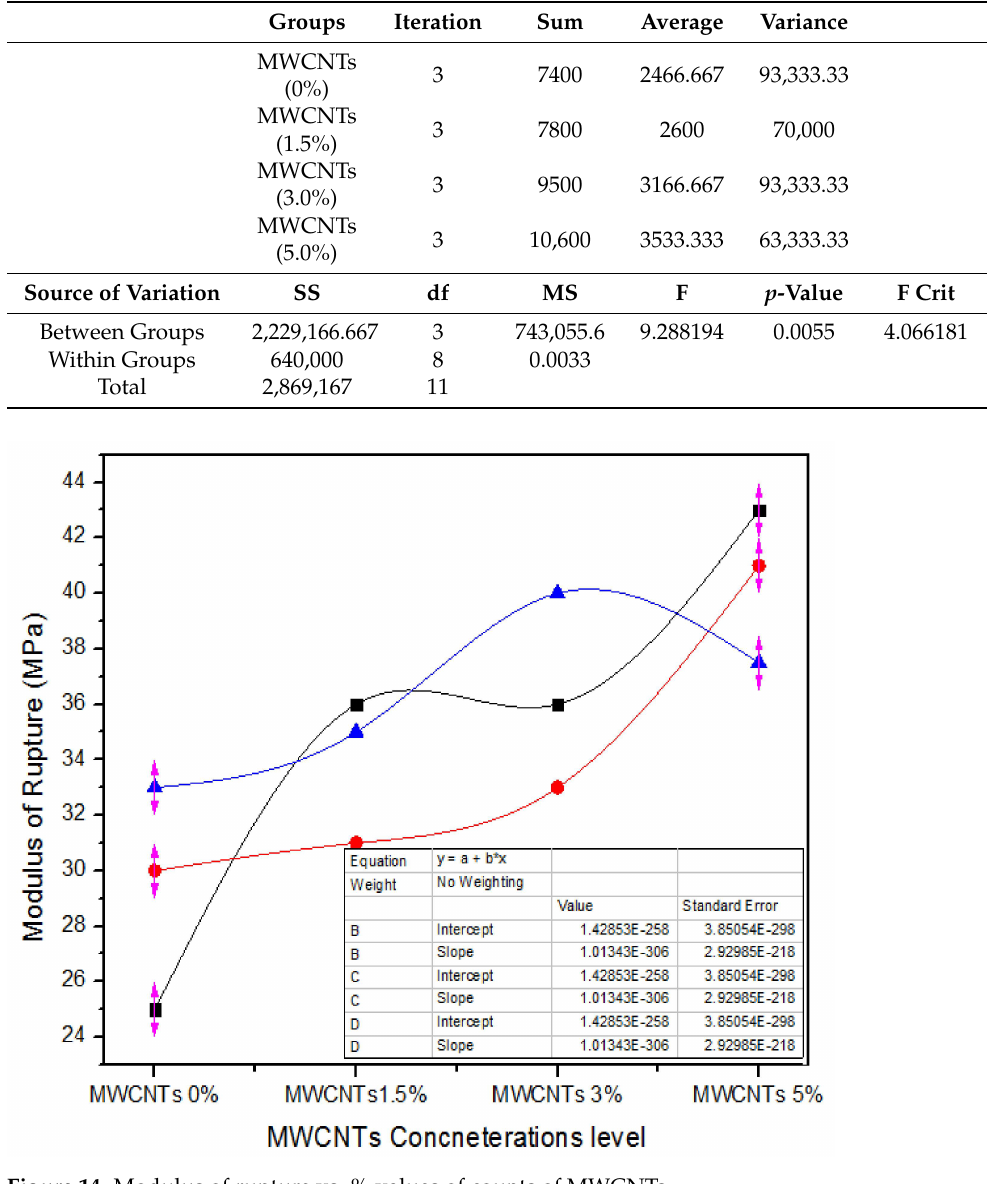
Figure 14. Modulus of rupture vs. % values of counts of MWCNTs. Table 11 briefly sums up a one-way ANOVA origin-based analysis of MOR parameters for the three counts of 0%, 1.5%, 3.0%, and 5.0% MWCNTs containing MDF. For the 0% MWCNTs concentration, the modulus of rupture mean value was 29.33 MPa and the vari- ance was16.33, while for the 1.5%, 3.0%, and 5.0% MWCNTs concentrations, the modulus of rupture mean values were 3436.33 and 40.5 with alterations of 7, 12.33 and 7.75, respectively. A one-way ANOVA results in p =